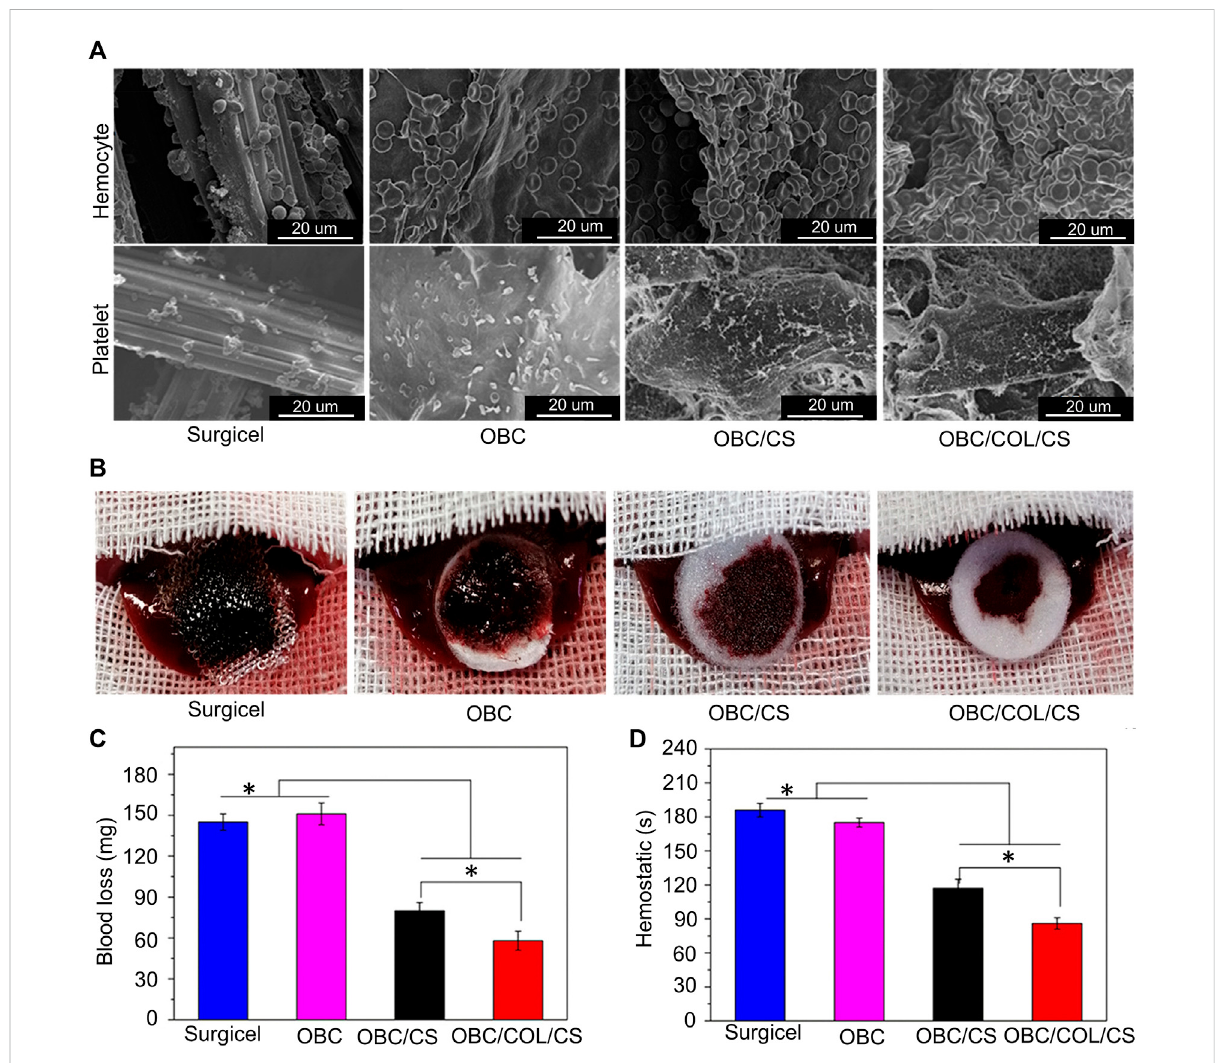
FIGURE 4 (A) SEM image of red blood cells and platelets adhering to the sample. (B) In vivo evaluation of the hemostatic capacity of the different complexes in a rat liver trauma model. (C) blood loss of the different complexes in a rat liver trauma model. (D) Time to hemostasis of the different complexes in a rat liver trauma model. Reproduced with permission from (Yuan et al.,